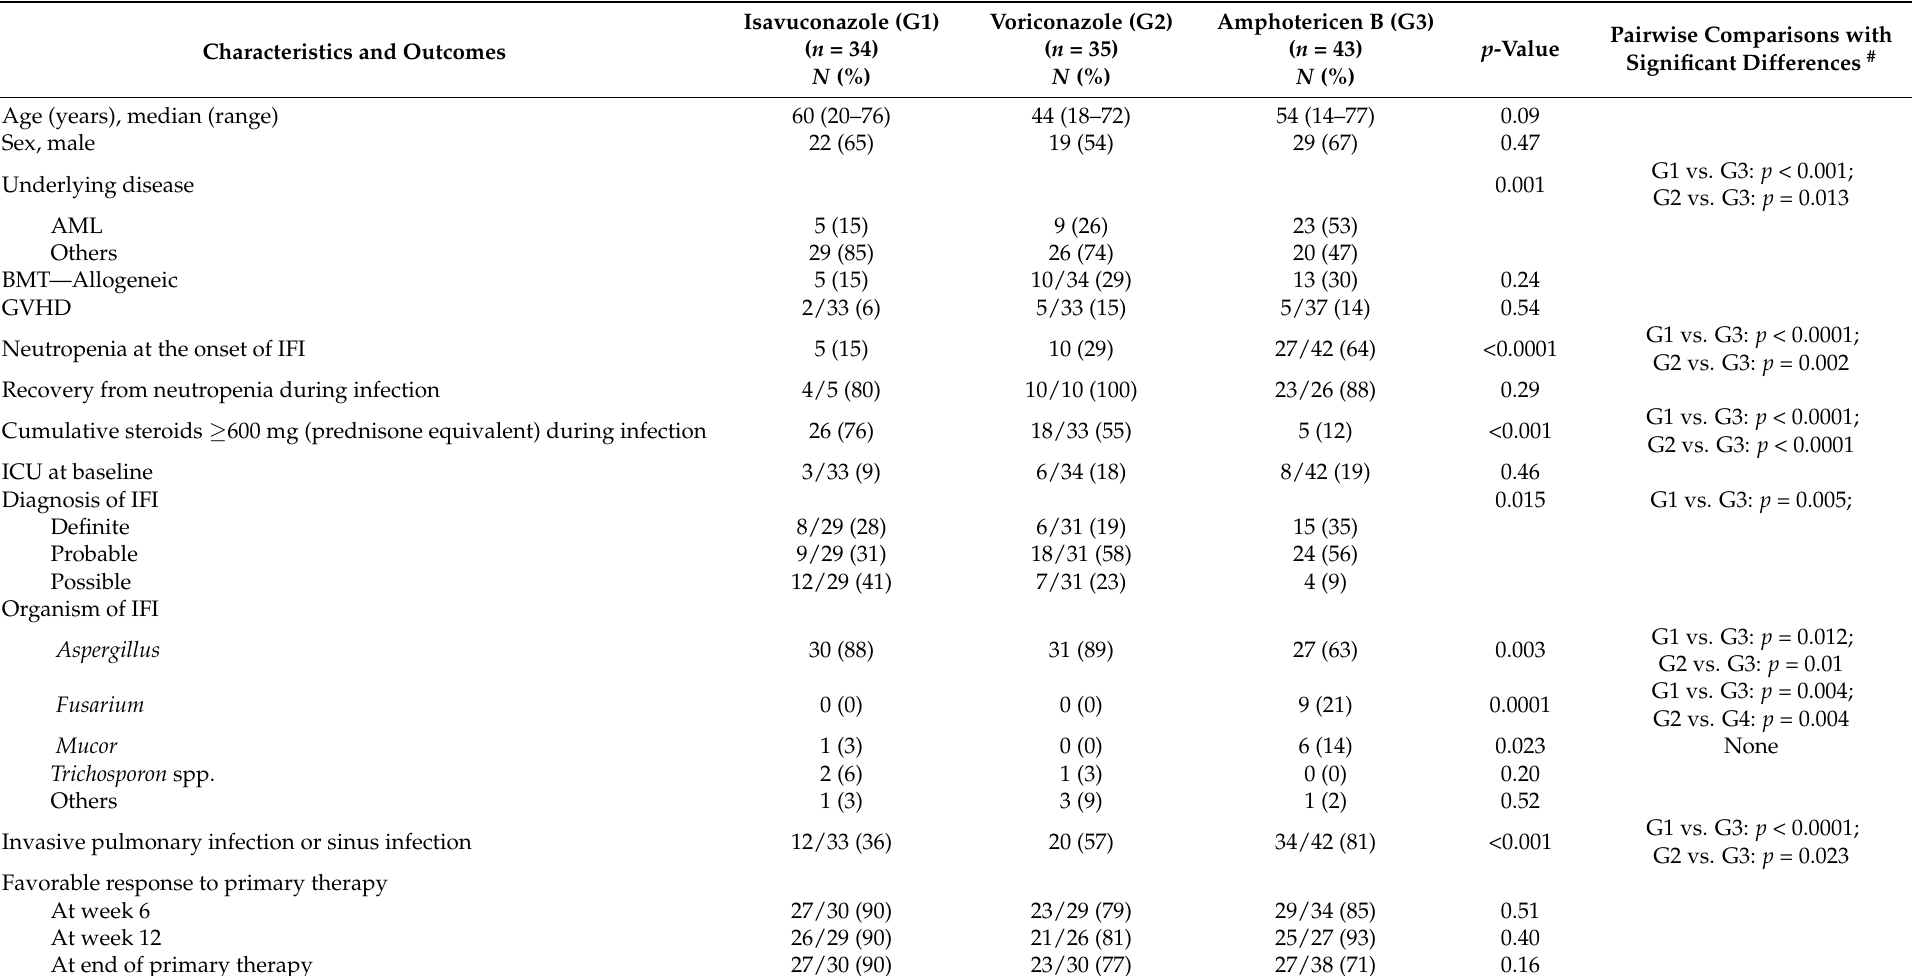
Table 2. Primary therapy